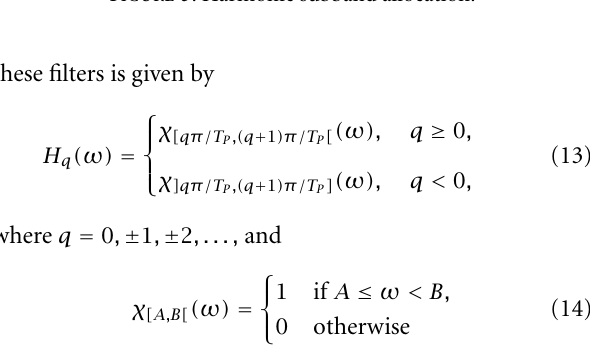
Figure 3: Harmonic subband allocation.